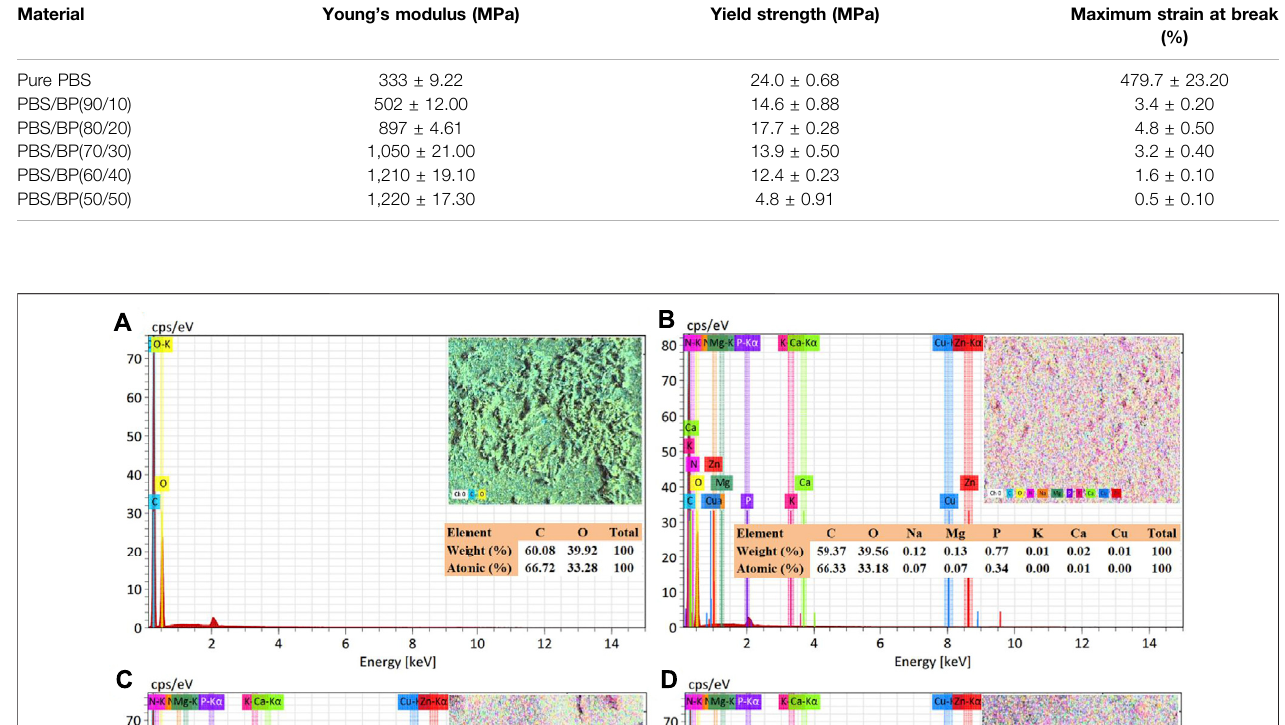
Frontiers in Materials |